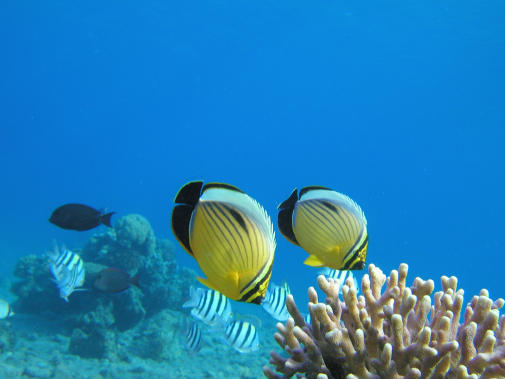
Ocean bacteria with the light-sensitive proteorhodopsin enzyme live several meters above this coral reef (Photo: Boaz Harel)